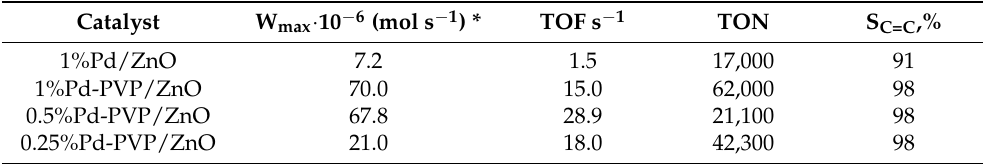
Table 3. Results of the hydrogenation of 3,7,11-trimethyldodecyn-1-ol-3 in ethanol on Pd catalysts. Catalyst